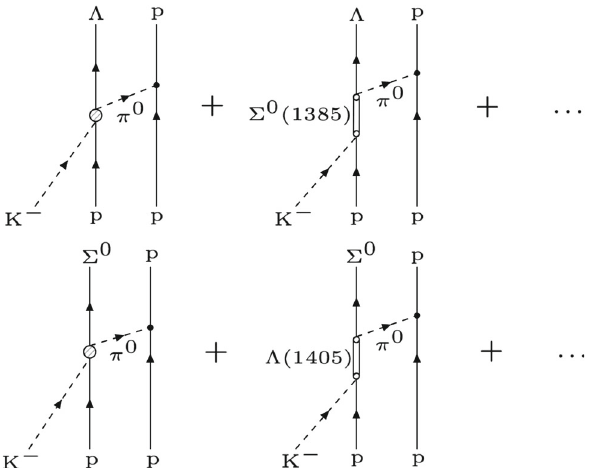
Fig. 5 The tree level (left) and the leading order (right) diagrams of the processes K − ( pp ) → (cid:2) p (top) and K − ( pp ) → (cid:3) 0 p (bottom), accord- ing to the meson exchange